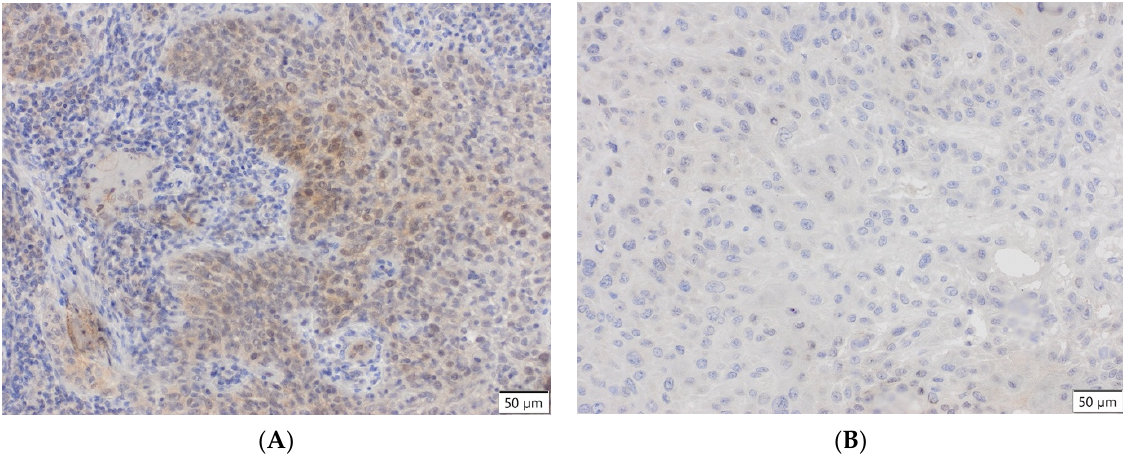
Figure 5. ( A ) ZNF-281-positive, 20×, scale bar 50 μ m. ( B ) ZNF-281-negative, 20×, scale bar 50 μ m.